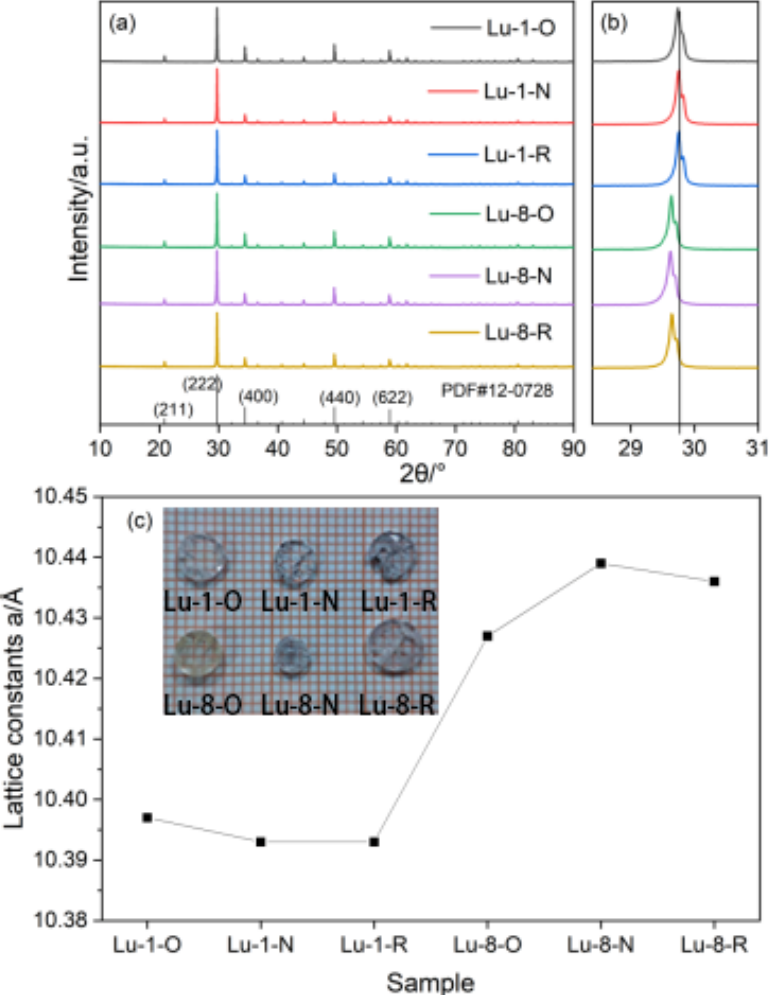
Figure 1. ( a ) XRD patterns of Lu 2 O 3 :1%Eu and Lu 2 O 3 :8%Eu single crystals grown under different atmospheres. ( b ) Range of 28 ‐ 31° for the sake of clarity. ( c ) Photograph of the samples and the calculated lattice constants a of the samples.